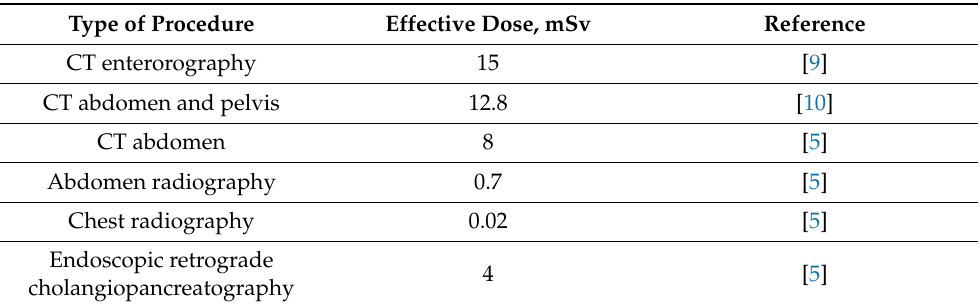
Table 1. Effective doses for most commonly performed diagnostic radiology